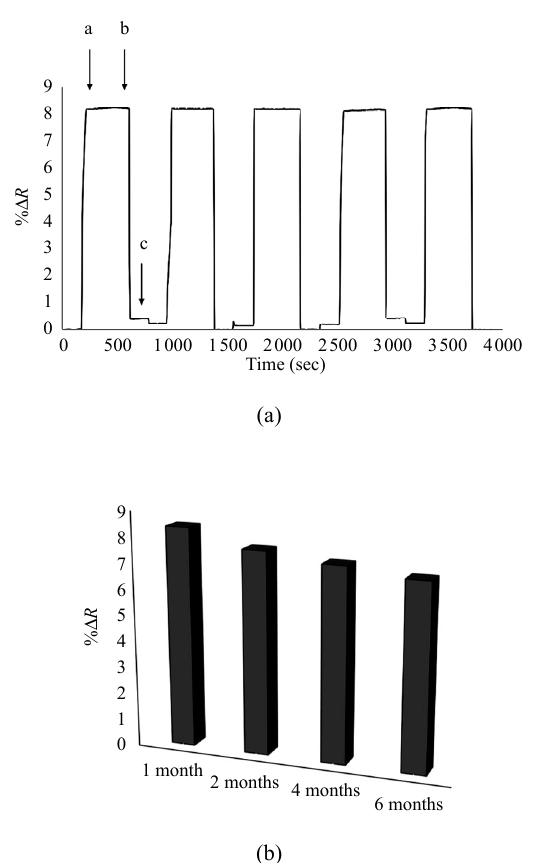
Fig. 9 Reusability (a) and storage stability (b) studies (a: adsorption; b: desorption; c: